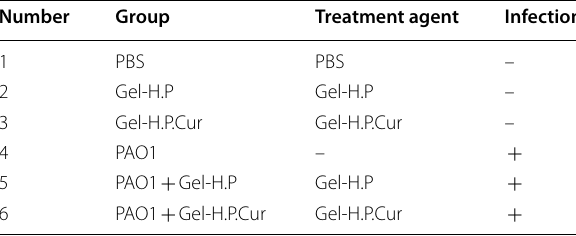
Table 1 Details of each group of incision wound model